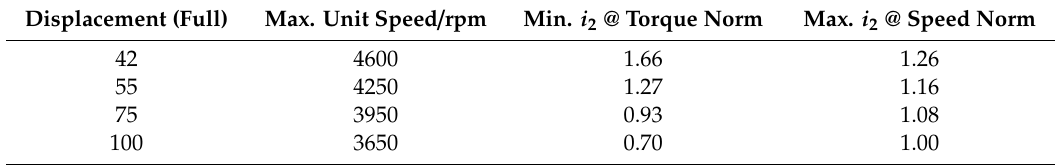
Table 5. PST Unit 2 selection lookup table